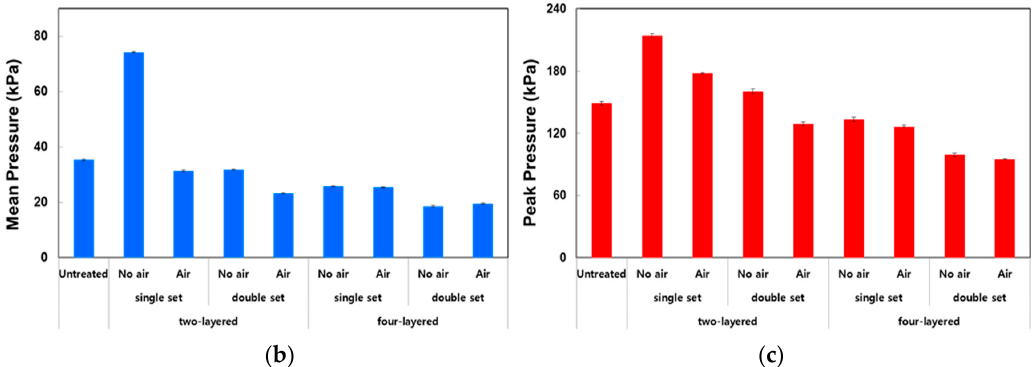
Figure 11. Pressure measurement results on the leg during loaded posture: ( a ) pressure distribution, ( b ) mean pressure, and ( c ) peak pressure.